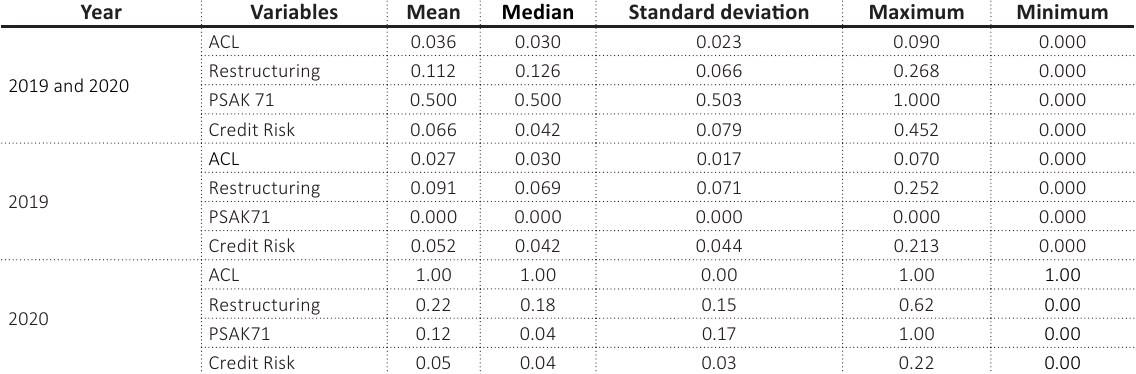
Source: Processed